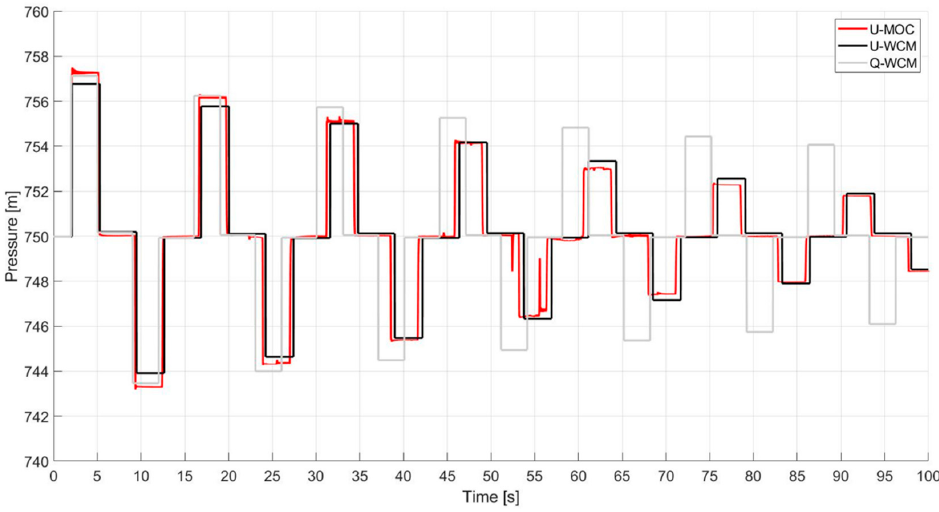
Figure 4. A comparison of the transient behavior at node 2 for the refined U-WCM (black) and the U-MOC (red) for the first case study—A variation. The quasi-model (Q-WCM) is illustrated in gray in the background.